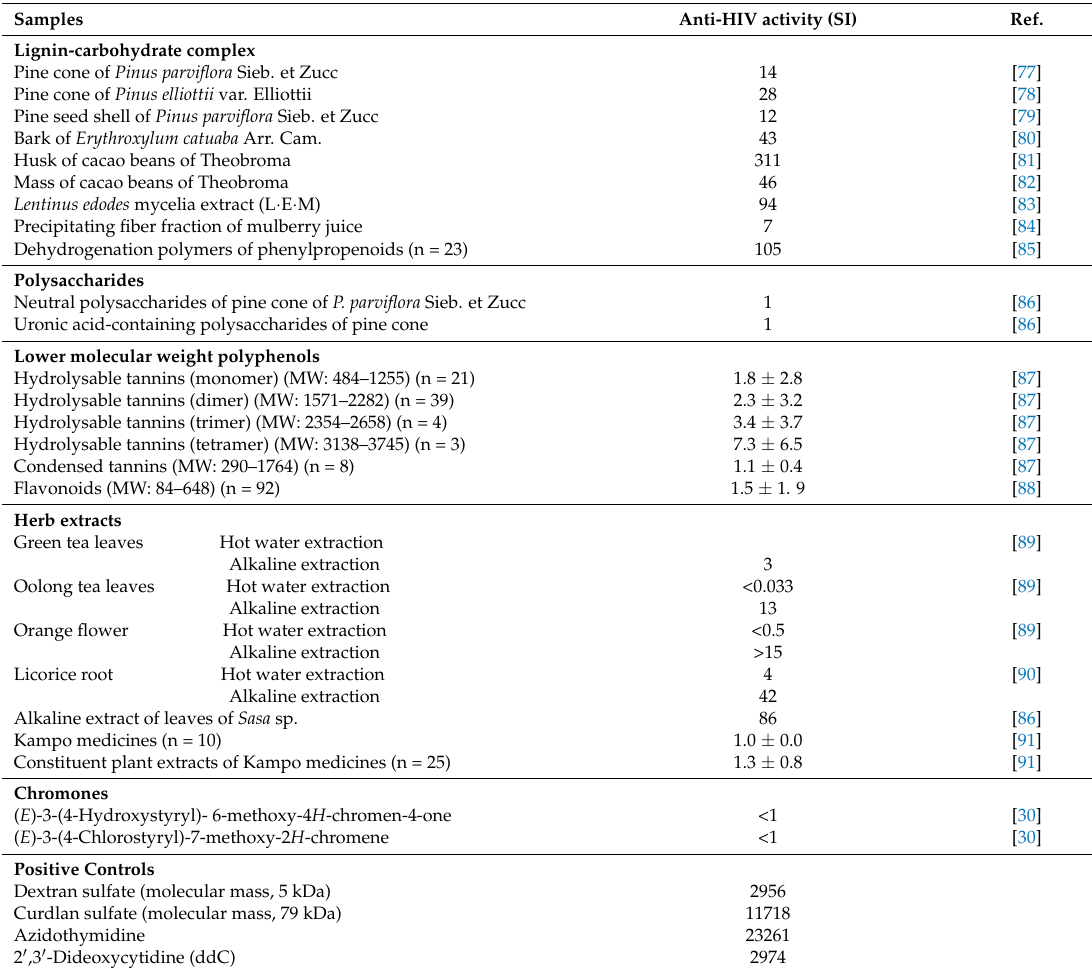
Table 3. Anti-HIV activity of natural